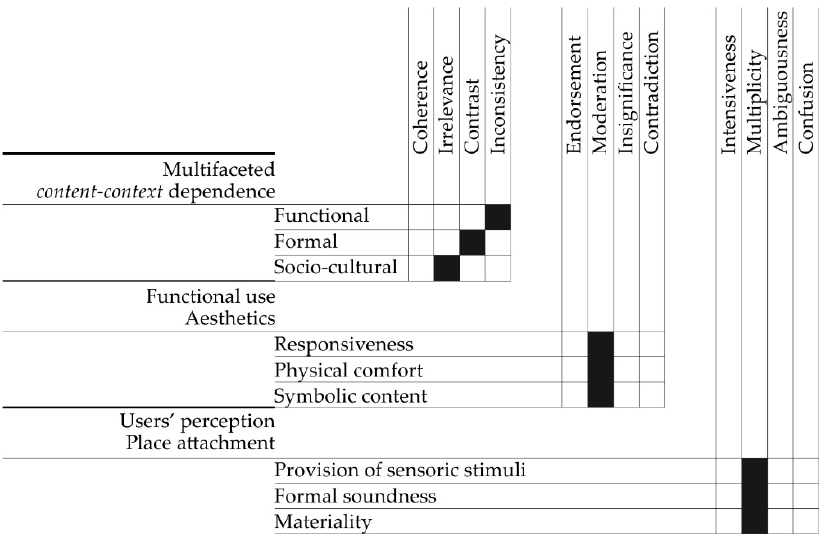
Figure 6. The qualitative evaluation of the area relation, determined in function to the application of building techniques, within main criteria group. Case study: Polish National Radio Symphony Orchestra House, Katowice.